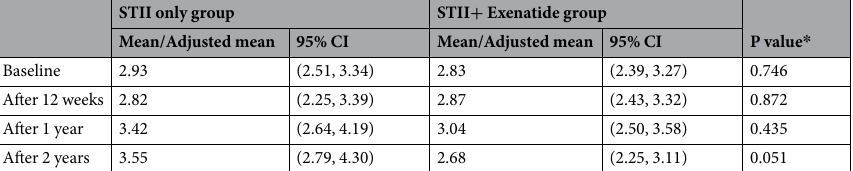
Table 1. Analysis of covariance (ANCOVA) and adjusted means (95% confidence interval (95% CI)) for laboratory and clinical parameters after the 12 weeks (after Exenatide therapy), 1 year and 2 years of STII therapy. * p < 0.05, p value for analysis of covariance (ANCOVA) between two groups with adjustment for the corresponding variables at baseline when necessary. HDL, high-density lipoprotein; HOMA, homeostasis model assessment; IR, insulin resistance index; LDL, low-density lipoprotein